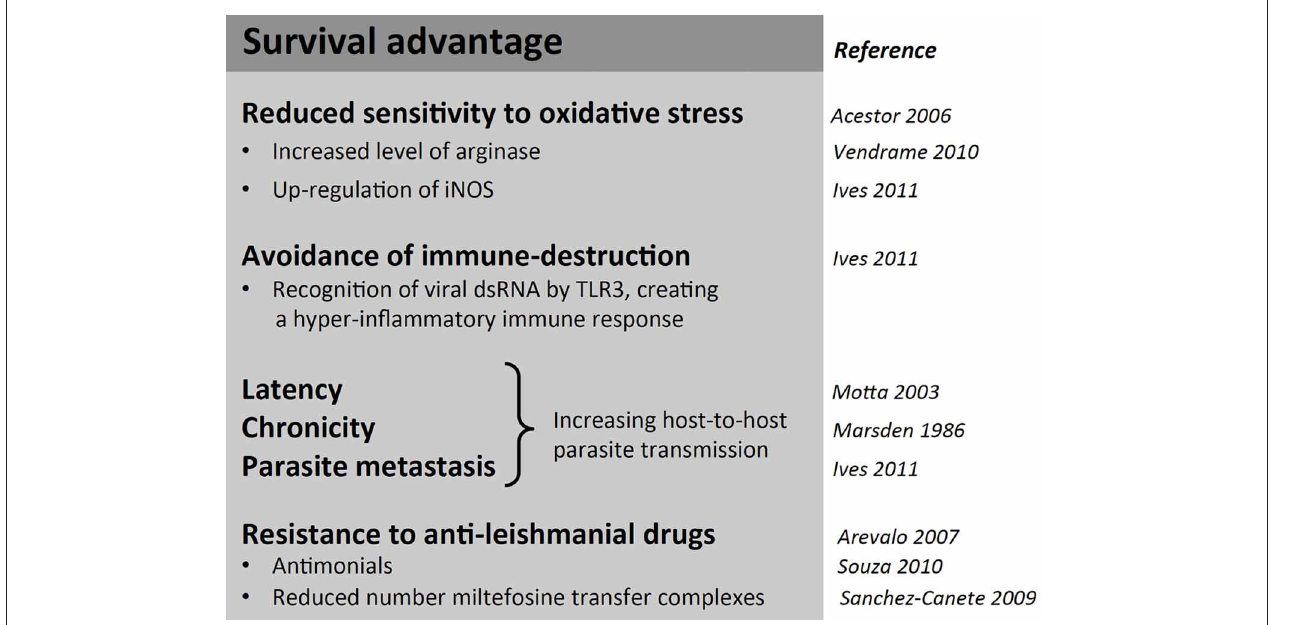
FIGURE 3 | Summary of possible survival advantages in Leishmania (Viannia) parasites associated with LRV infection. Despite the metabolic and translational toll on the host, LRV infection is associated with some benefits in survival advantages for its host